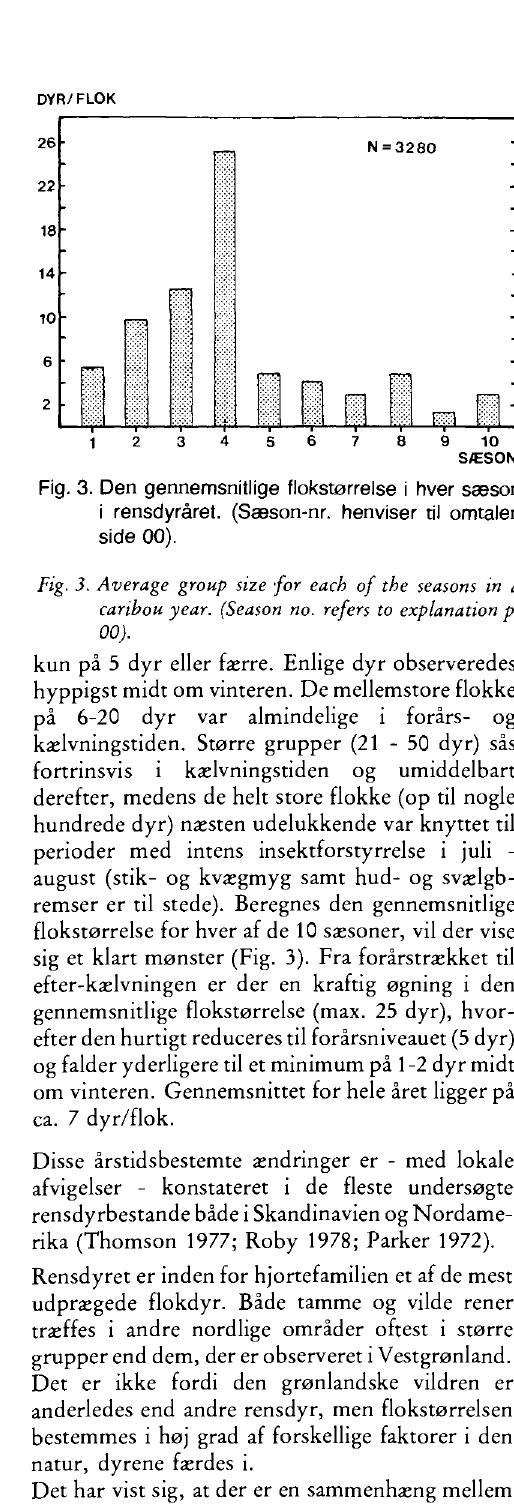
Fig. 4. Fordeling af køns- og aldersklasser i bestanden 1977—79. Fig. 4. Relative size of sex and age classes in thepopulation